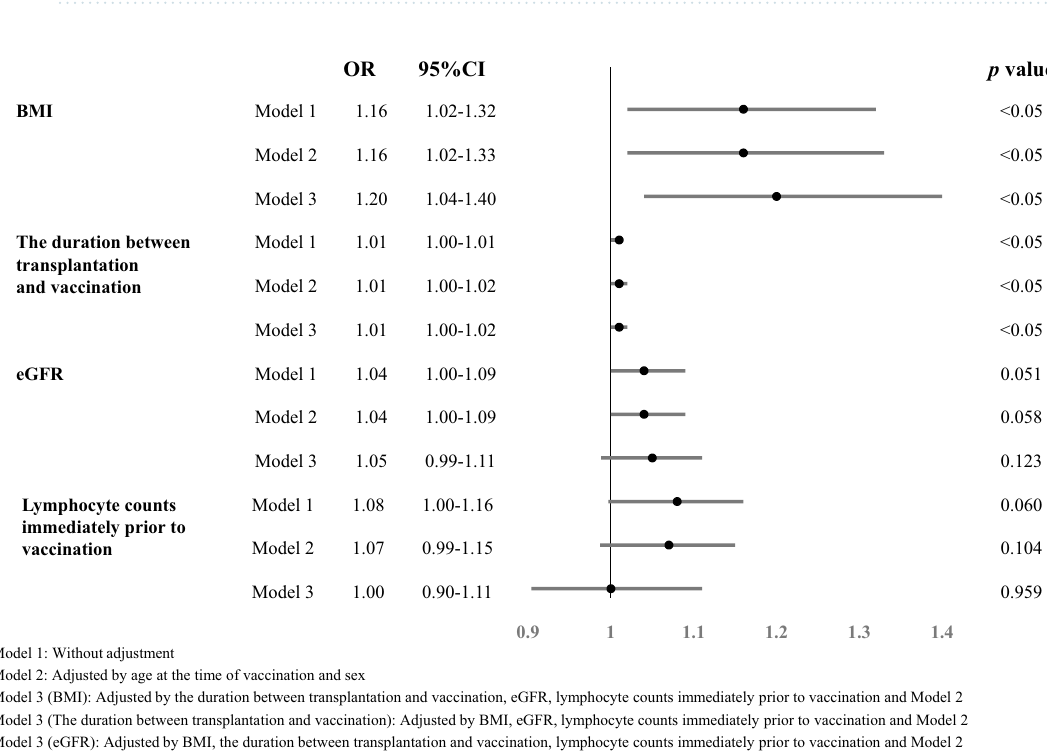
Figure 4. Clinical factors associated with low antibody acquisition rates of post-kidney transplant patients. Odds ratios for lymphocyte counts are shown per 100 cells/uL. OR, odds ratio; CI, confidence interval; BMI, body mass index; eGFR, estimated glomerular filtration